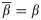
Total number of infected cells for varying viral infectivity, β, and maximum CTL response, k.The density plots in the top three rows show the number of infected cells at stationary state for different β and k (note that in the simulations, mean viral infectivity varies across patches, and therefore mean viral infectivity β¯=β is plotted). Results are shown without and with a reservoir included in the model, and for a low effective migration rate (Me = 0.25 per day, δB = 432 per day) and a high effective migration rates (Me = 2.4 per day, δB = 1 per day). For the single patch model, the black line shows the extinction threshold above which the viral population cannot be sustained in the absence of a reservoir. For the analytical approximation, the area between the solid black lines shows where introduction of infection in an uncolonised patch is followed by a within-patch burst, and the dashed line indicates where the patch reproduction number RP = 1, thus distinguishing whether, in the absence of a reservoir, the virus goes extinct or an SMSS can be sustained. To the right of the SMSS region, a full equilibrium (FE) is predicted, and to the left, a trivial equilibrium exists. The areas in white are those where no infected cells are present. For the simulation, the area between the black solid lines shows where an SMSS is observed, defined as where both the viral population has not gone extinct and the mean CTL response across all patches is less than 99% of the maximum CTL response. The bottom two rows are transects across the density plots shown above them, with either viral infectivity held constant (β = 10 per day) or the maximum strength of the CTL response held constant (k = 10 per day). Single patch model, grey-scale gradient and back transect line; analytical approximation of the metapopulation model, red-scale gradient and red transect line; simulation of the metapopulation model, blue-scale gradient and blue transect dots. All other parameters are as described in Table 1.